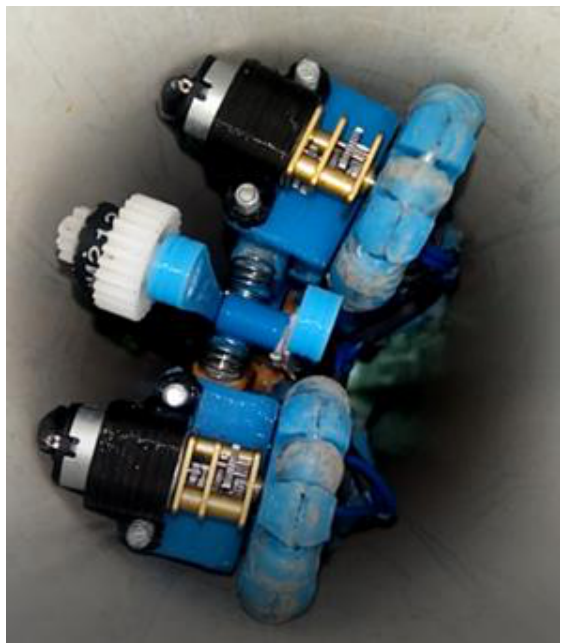
Figure 10. Control robot position due to the joystick and the omnidirectional wheels.